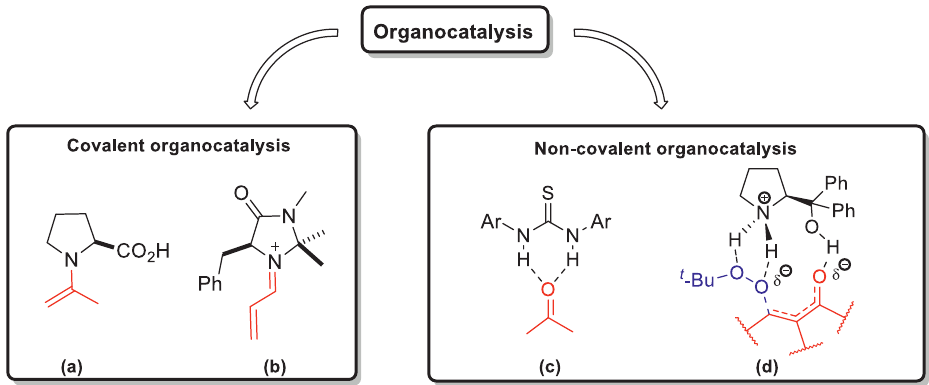
Figure 4 . The fi eld of organocatalysis is divided into two main areas, depending on the interactions involved in the mechanism. Some exemplar cases are reported in the fi gure. Substrates are red coloured, catalysts are black and in case (d) the oxidant is blue.